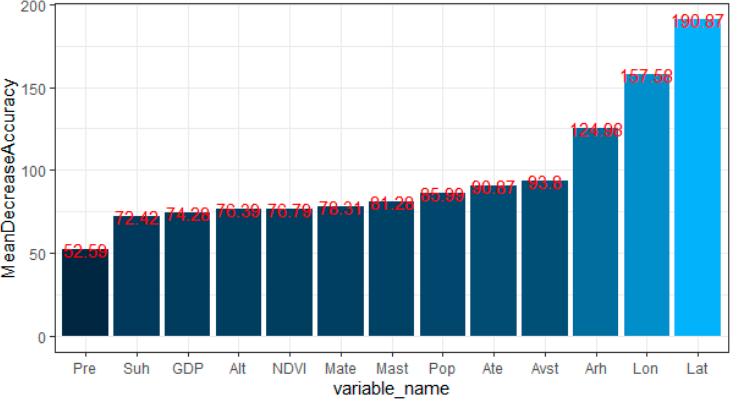
Figure 10. Mean decrease accuracy of 13 variables.